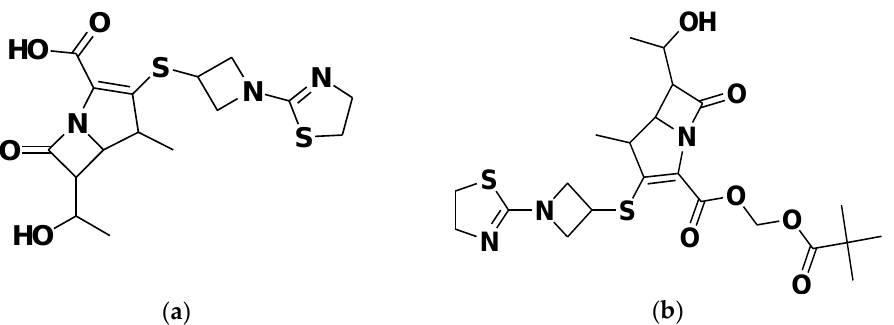
Figure 3. Chemical structure of tebipenem ( a ) and of the tebipenem prodrug tebipenem pivoxil ( b ). The chemical structures were drawn using the ChemDraw Ultra 7.0 software (Chem Office 2002).